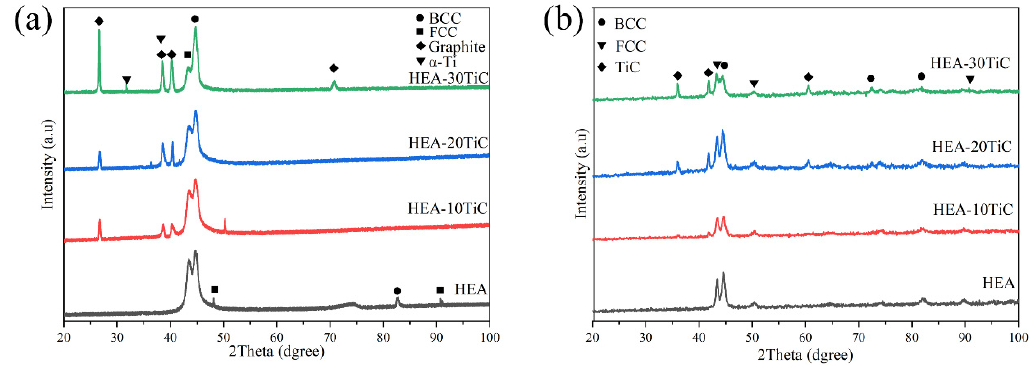
Figure 1. XRD patterns of ( a ) HEA-TiC composite as-milled powders and ( b ) as-SPSed HEA-TiC composites.